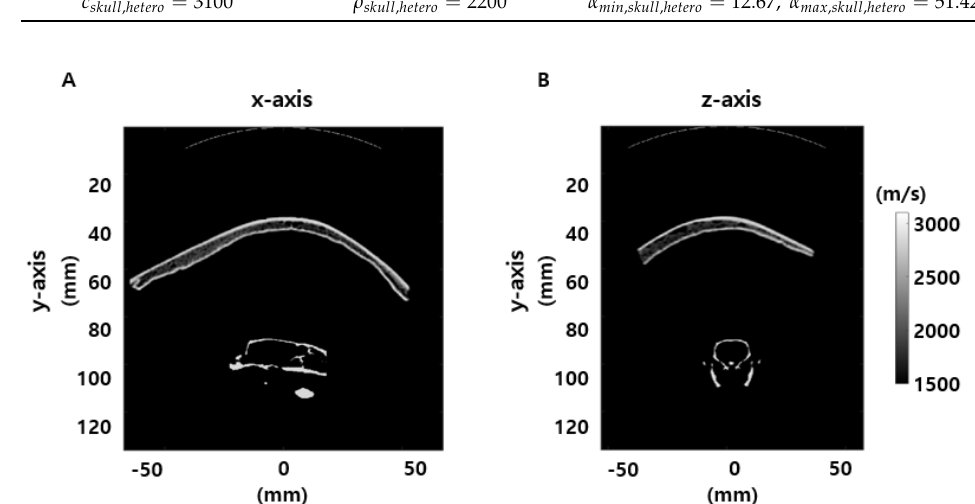
Figure 3. Sound speed field (m/s) for simulations in human skull flap in conjunction with entire rat skull with a representation of the transducer. ( A ) Sagittal view. ( B ) Axial view.